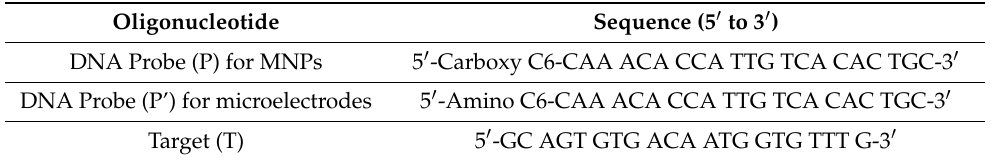
Table 1. Sequences of oligonucleotide strands.